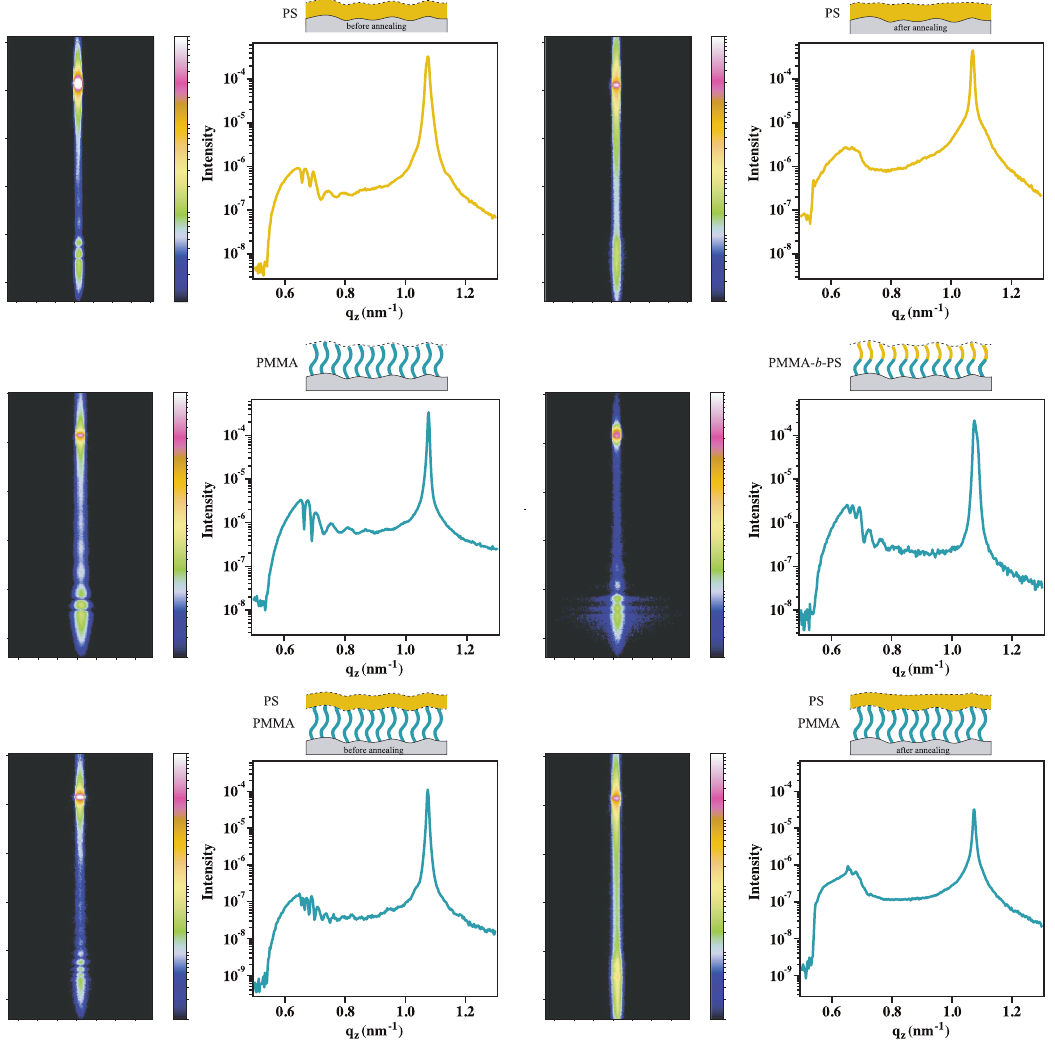
Figure 11. GISAXS detector images and q z detector line cuts of spin-coated PS films with and without annealing, PMMA brushes, PMMA- b -PS block-copolymer brushes and spin-coated PS films on top of PMMA